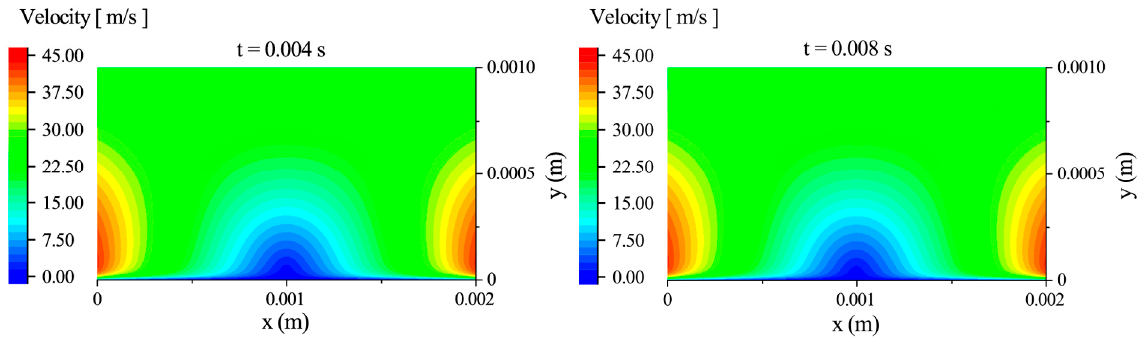
Figure 10. The velocity contour of the water-based ink drying.